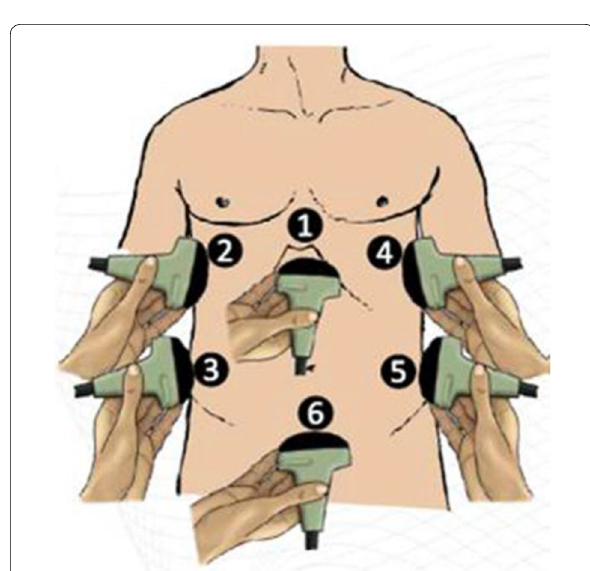
Fig. 2 Schematic drawing of the ultrasound probe positions during the FASH examination [17]